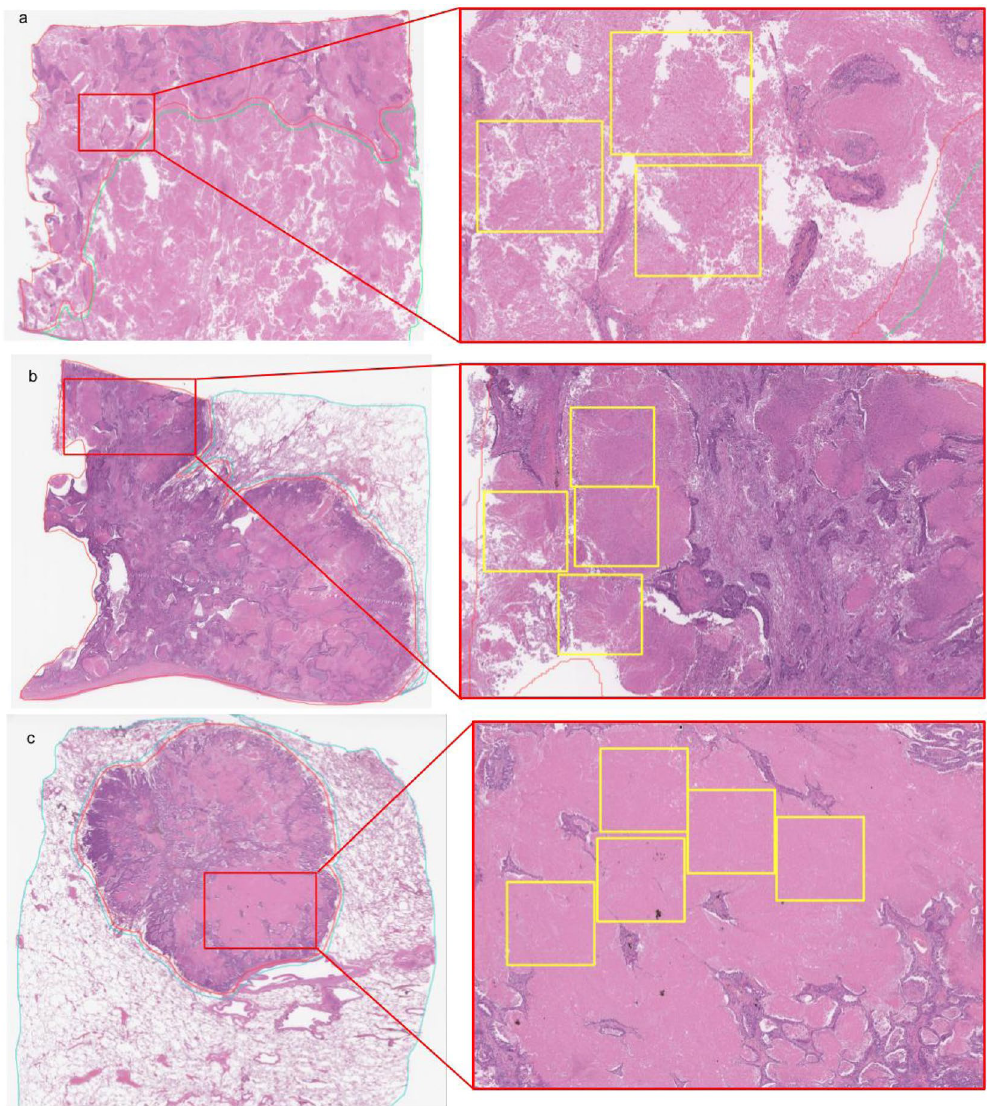
Figure 1. ( a – c ) Highlights showing three examples of carcinoma WSI annotations. The left column shows thumbnails of the WSIs, while the right shows zoomed-in crops from regions labelled as carcinoma. The yellow boxes indicate necrotic tissues within the tumour. Extracting tiles from tissue within yellow boxes would result in tiles consisting of necrotic tissue labelled as carcinoma. This would introduce noise within the dataset as necrotic tissue can also be part of non-neoplastic